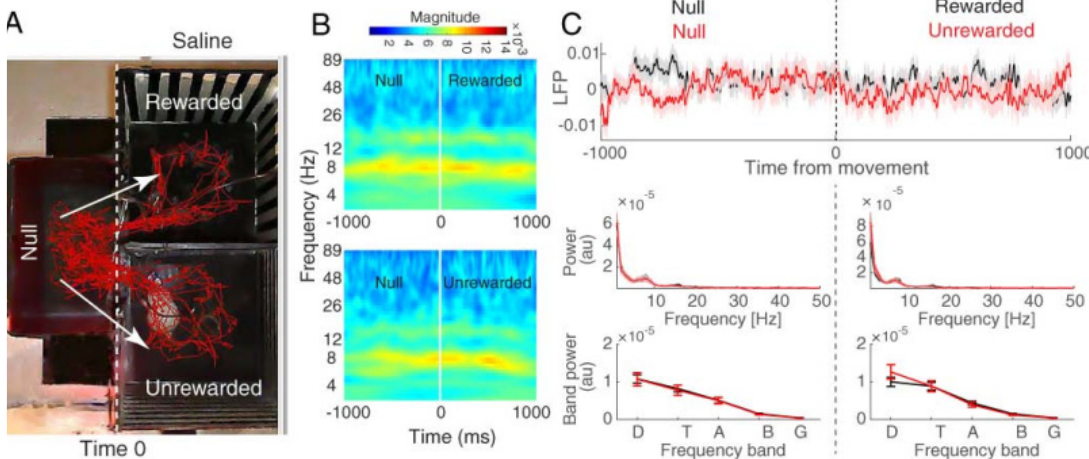
Figure 3. Hippocampal CA1 local field potential of the saline group. ( A ) Behavioral tracking of animals during LFP recording in the post ‐ test session of CPP (red line), animals received saline in both rewarded and unrewarded sides. The dashed line indicates the time that the rat chooses to enter rewarded or unrewarded side from null. The time window was defined as one millisecond before and after the entrance to each side (null–rewarded and null–unrewarded sessions). ( B ) Time–frequency representation based on CWT averaged across all recording trials and aligned to chamber entry. Time zero is defined as the time of entrance to each side from null (shown by the dashed line). ( C ) Total averaged LFP signals (top) and mean power distributions (bottom) for the approach to the rewarded (black) and unrewarded (red) compartment calculated over a time window of one second before and one second after chamber entry. Shaded areas represent SEM.